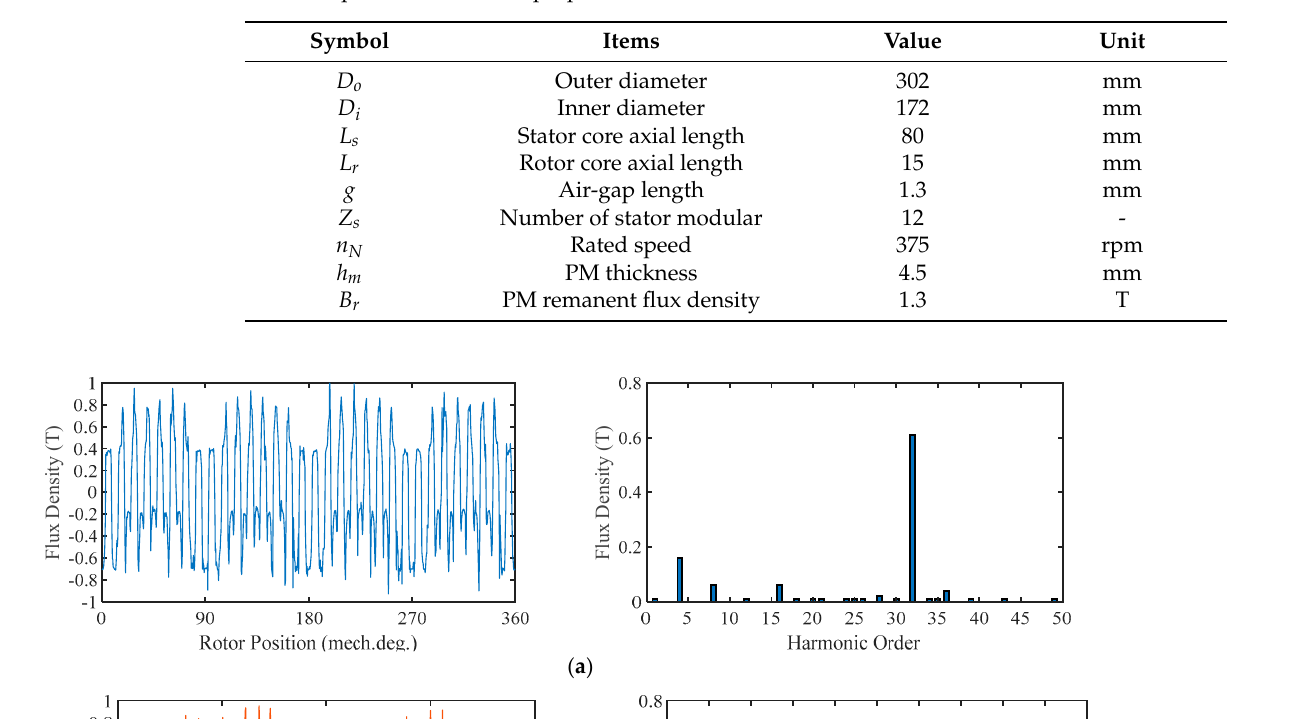
( b ) Figure 5. Open–circuit phase flux linkage waveforms and harmonic spectra with different PRs. ( a ) Flux linkage waveforms. ( b ) Harmonic spectra. 3.2. Flux-Weakening Characteristic The FE predicted magnetic field vector distribution of DR-HEAFPMVM with a PR of 8/1 as an example fed by a negative 10 ampere DC excitation current under zero armature windings current is shown in Figure 6. It can be seen that the PM excited field that should axially pass through the main stator teeth is bypassed by the DC excited field on the two- outer split-teeth, resulting in the reduction of the armature winding flux linkage. The